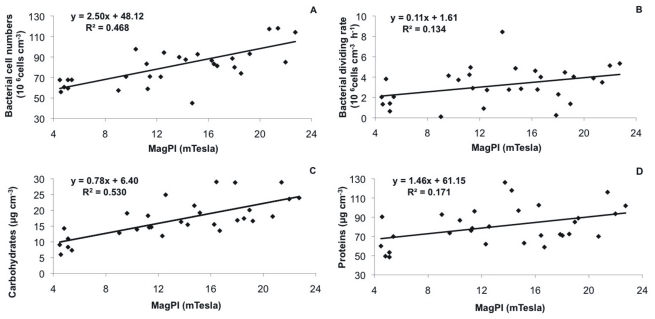
Scatter plot (n = 30) to show the relationship between bacterial biofilm adhesion expressed by MagPI (mTesla) versus bacterial cell numbers (A), bacterial division rates (B), EPS carbohydrate concentrations (C) and EPS protein concentrations (D).